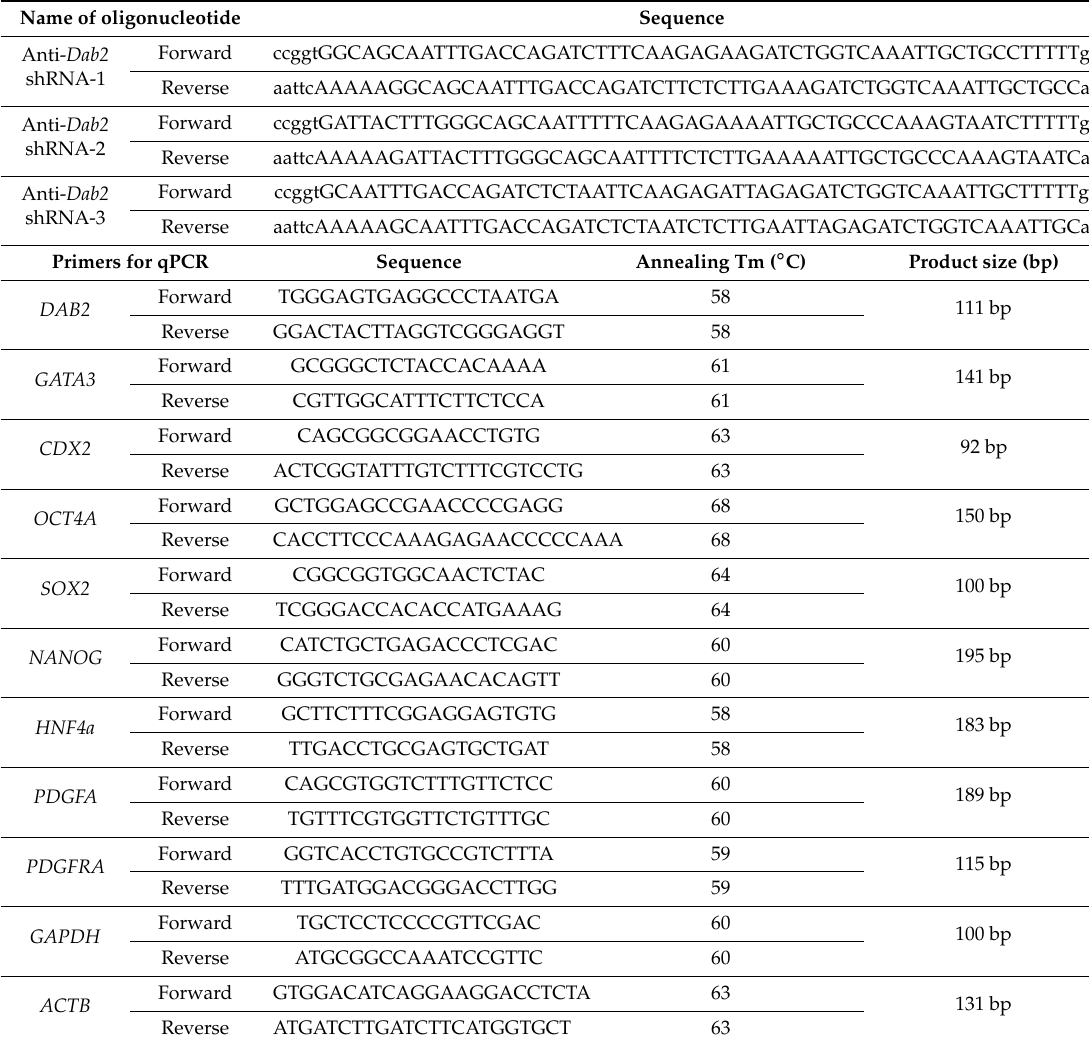
Table A1. Oligonucleotide sequences used in shRNA cloning and quantitative